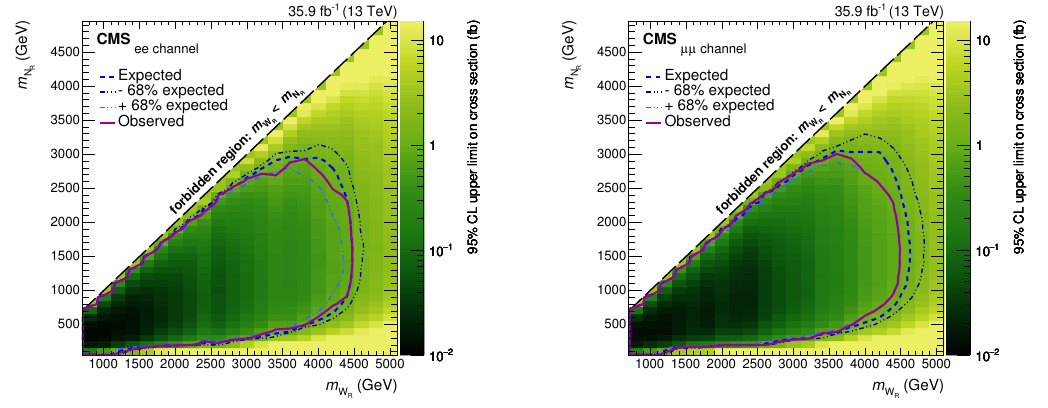
Figure 6 . Upper limit on the cross section for di(cid:11)erent W R and N R mass hypotheses, for the electron channel on the left and for the muon channel on the right. The expected and observed exclusions are shown as the dotted (blue) curve and the solid (red) curve, respectively. The thin- dotted (blue) curves indicate the region in ( m W excluded at 68% CL in the case that no signal is present in the data. range of right-handed neutrino masses is excluded at 95% con(cid:12)dence level. A W decaying into a right-handed heavy neutrino with a mass m